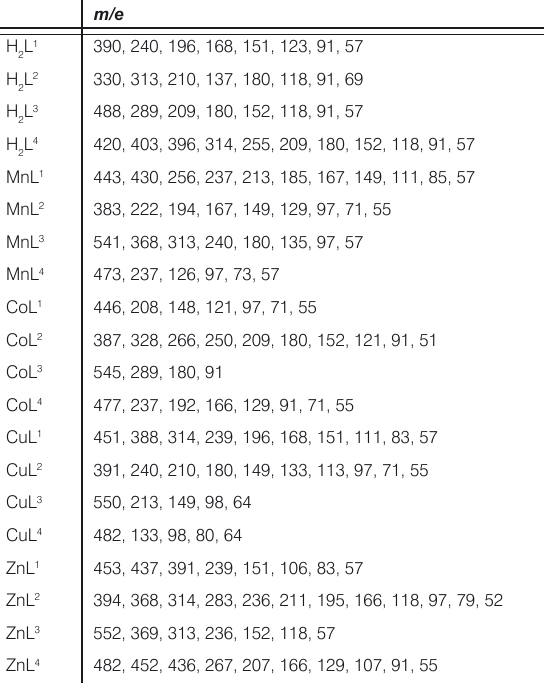
Table 2. Mass spectral data of the Schiff bases and their